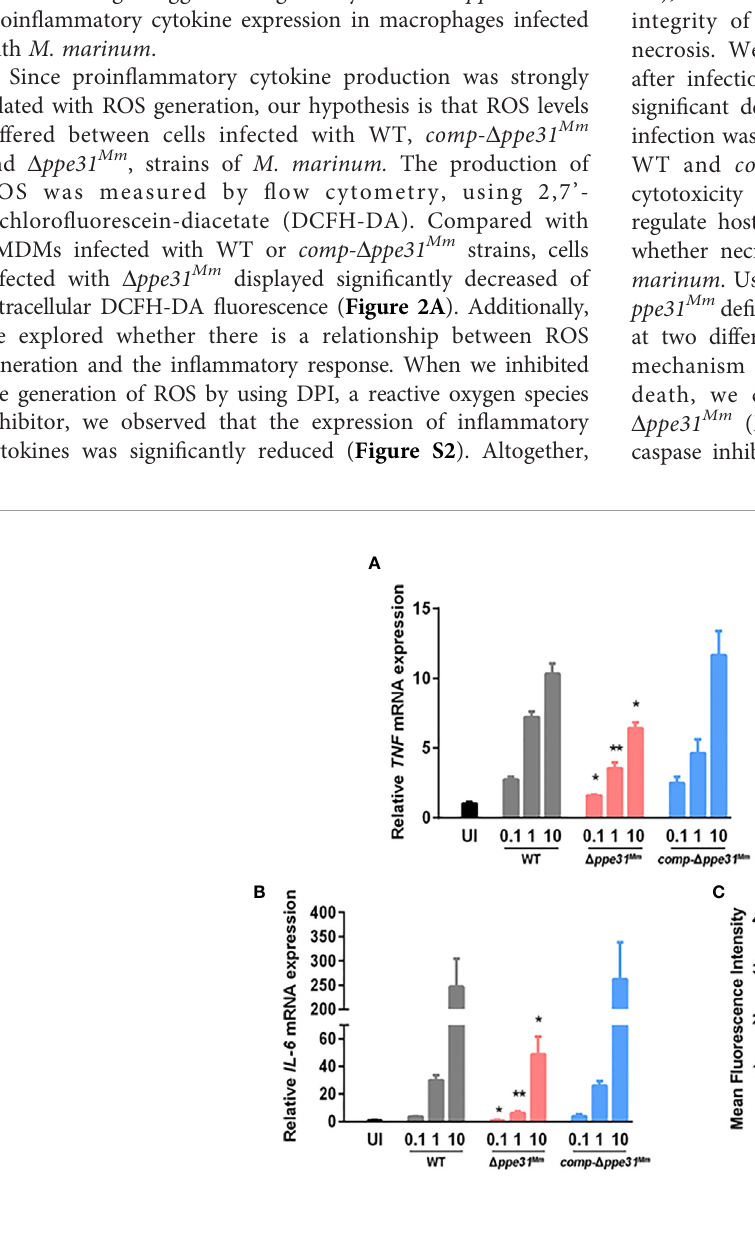
FIGURE 2 | D ppe31 Mm infection fails to partly induce the expression of proin fl ammatory cytokines and ROS generation in BMDMs. BMDMs were infected with WT, D ppe31 Mm , or comp- D ppe31 Mm at different MOIs (0.1, 1 and 10) for 6 h. The level expressions of in fl ammatory cytokines, TNF (A) and IL-6 (B) were assessed by RT-qPCR. (C) BMDMs were stimulated with WT, D ppe31 Mm or comp- D ppe31 Mm for 30 min. Cells were then labeled with DCFH-DA that were used detecting cytosolic ROS, and were analyzed for cytosolic ROS levels using fl ow cytometry. Data are shown as mean±S.E.M. of three independent experiments. * p < 0.05, ** p < 0.01, *** p < 0.001. WT, wild-type M. marinum ; UI,